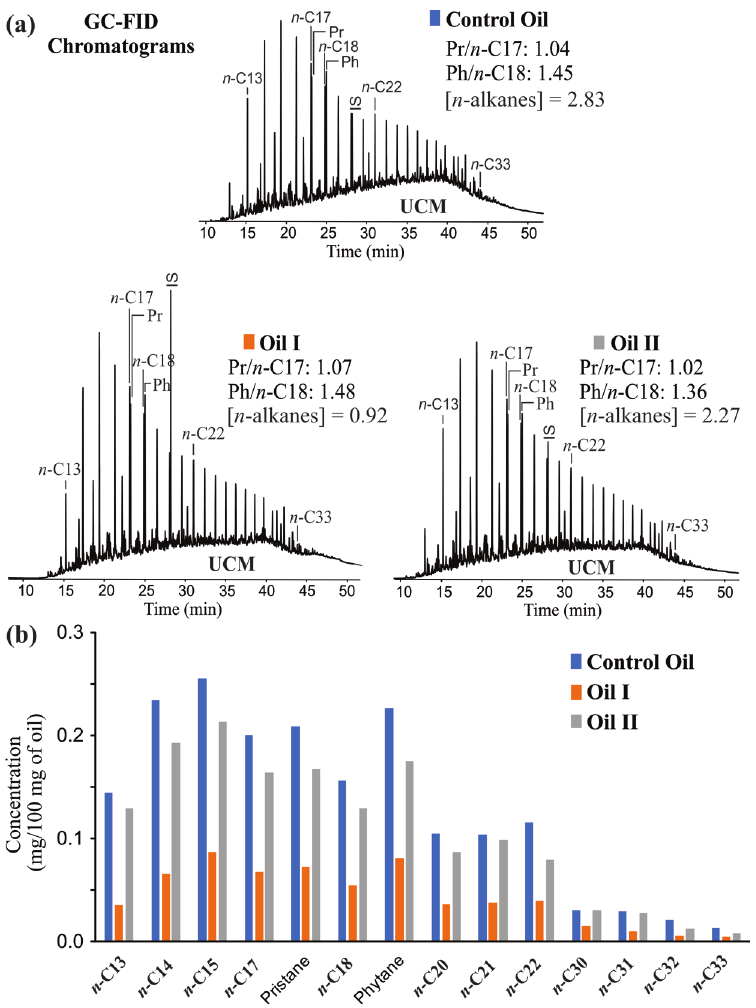
Figure 1. (a) Chromatographic profiles gained by GC-FID analyzes of the three oil samples, presenting the total concentration of n -alkanes in mg per 100 mg of oil. (b) The individual concentration of n -alkanes and isoprenoids pristane (Pr) and phytane